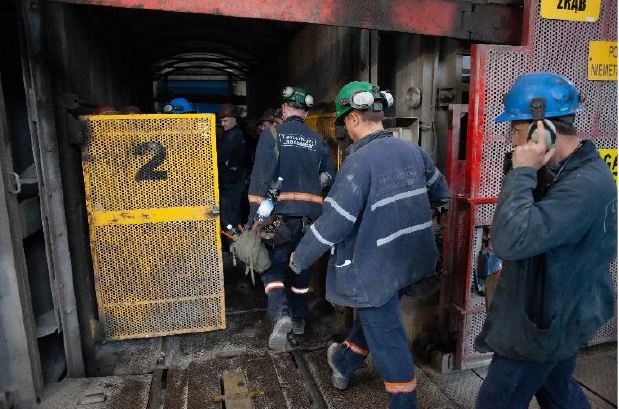
Figure 5. A coal mine top shaft in LW Bogdanka S.A. Source: photo provided by LWB.